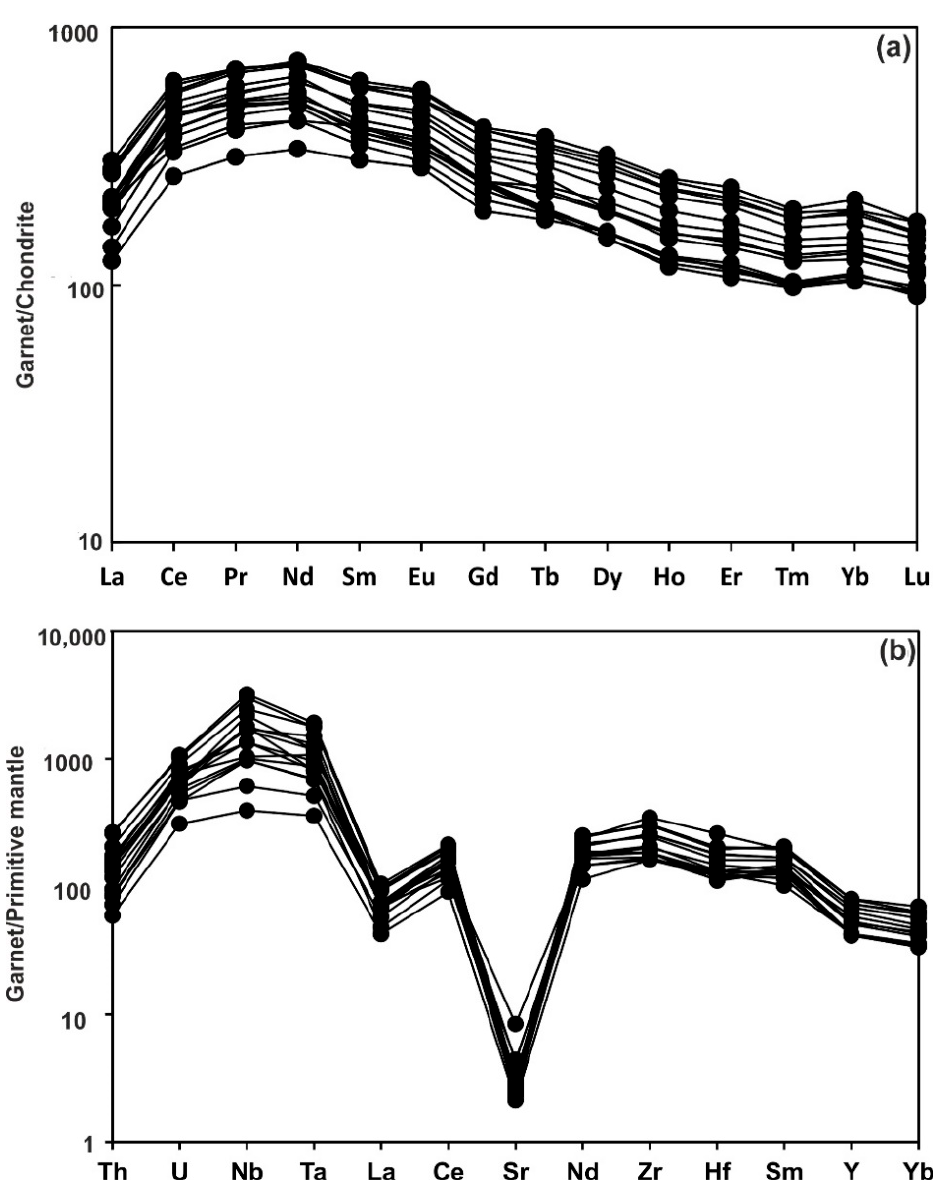
Figure 5. EPMA line scans along the line A–B (as shown in Figure 4a) for various oxides in the studied garnet grain.